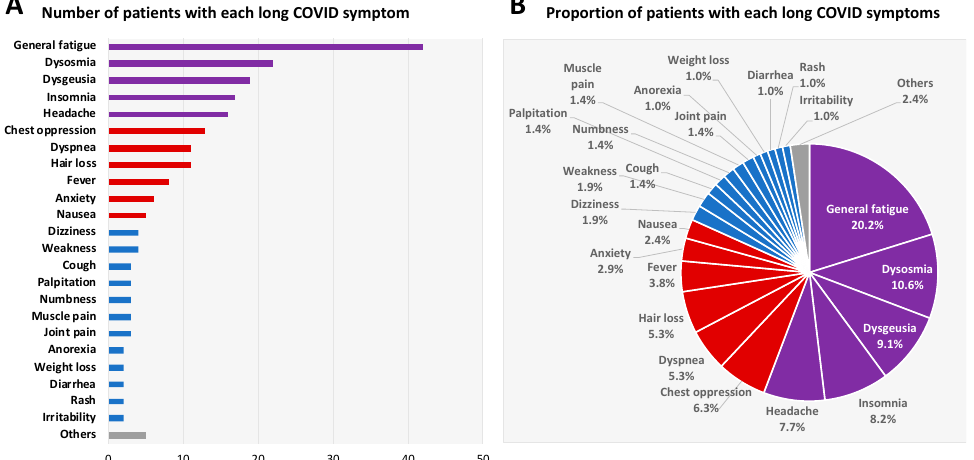
Figure 1. Number of patients and proportion of patients with each long COVID symptom at the initial visit. Number of the patients ( A ) suffering from each symptom in the 65 patients and the proportion of patients ( B ) with each symptom of long COVID are shown. The 5 most frequent symptoms were general fatigue, dysosmia, dysgeusia, insomnia, and headache (purple) and the next 5 most frequent symptoms were chest compression, dyspnea, hair loss, low-grade fever, anxiety, and nausea (red).